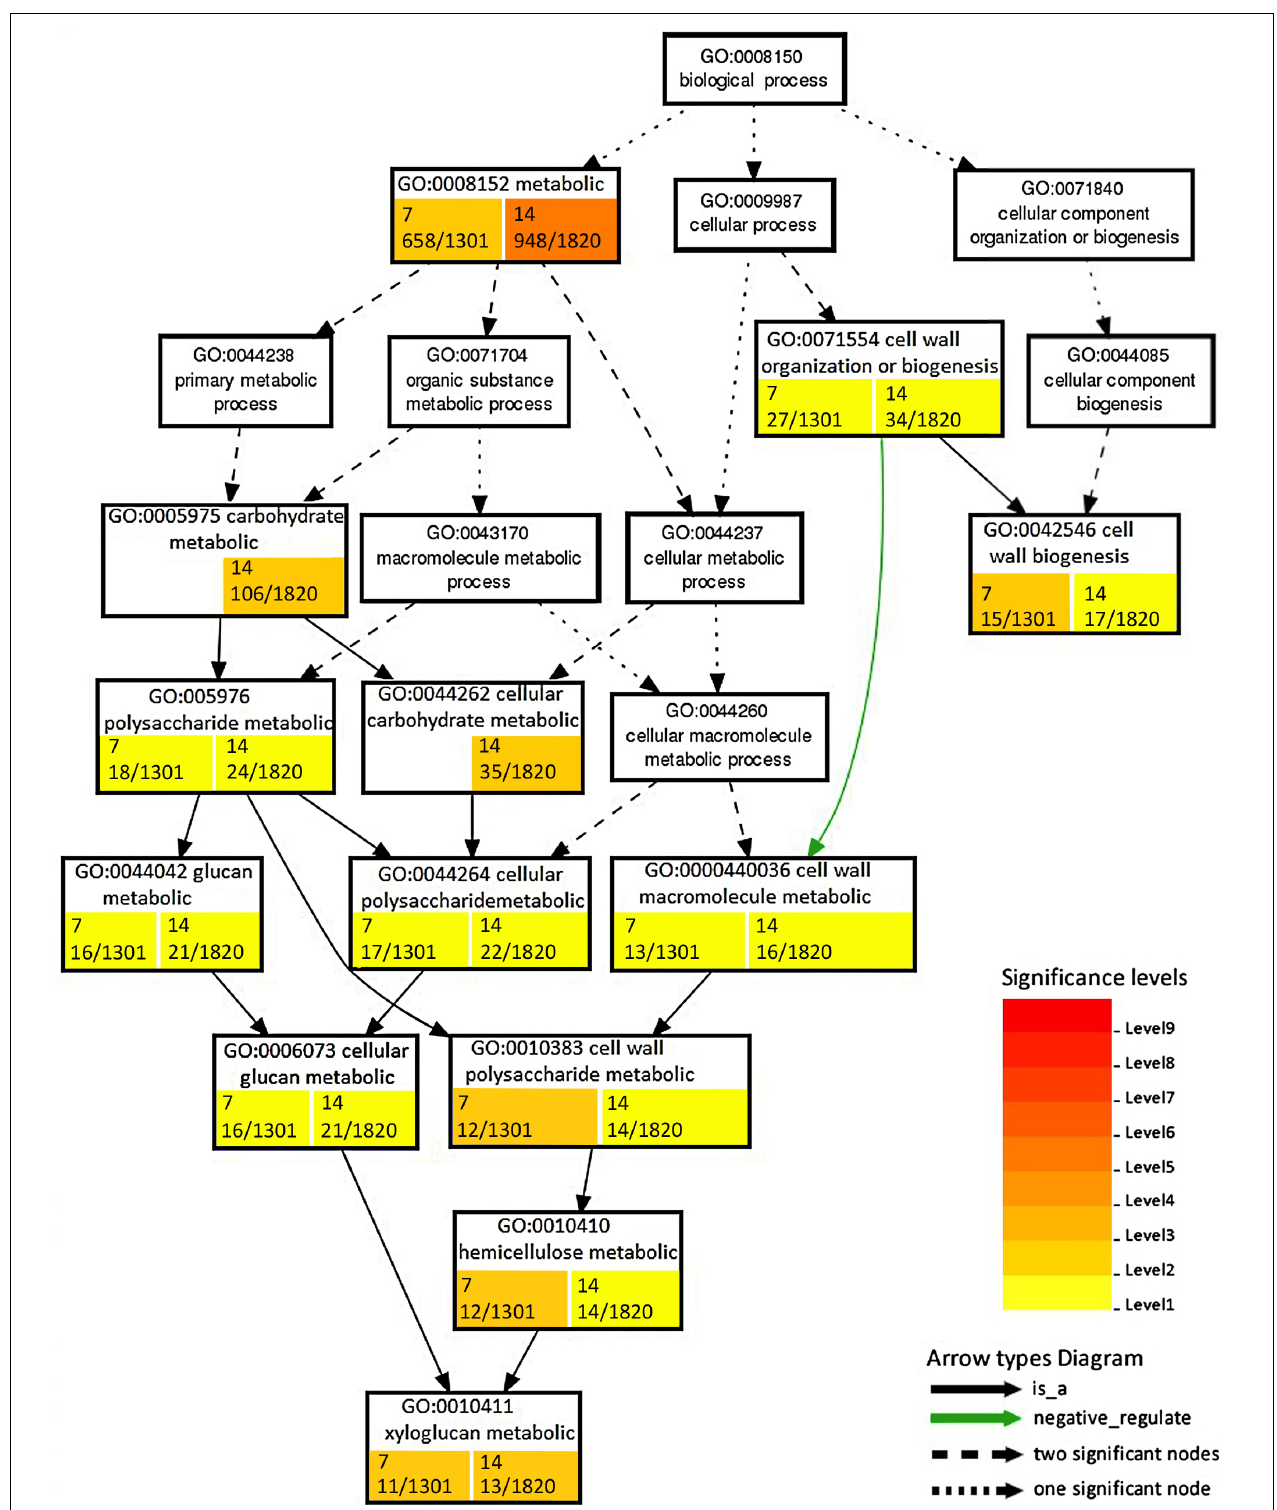
FIGURE 4 | Enrichment analysis of RKN_WS DEGs using Gene Ontology (GO) terms in the “Biological process” related to cell wall. Number of DEGs ascribed to each GO category with respect to total DEGs considered in the analysis are shown in colored box at 7 and 14 dpi. Color is proportional to the level of significance, as indicated by the scale in the